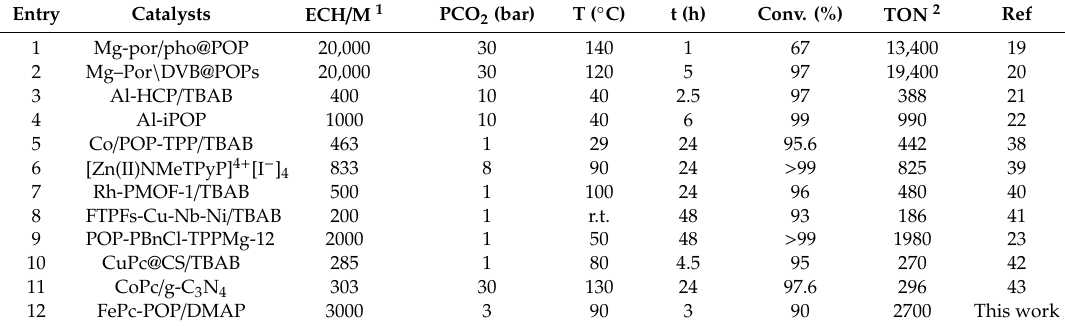
Table 3. Catalytic performance of heterogeneous porhyrin or phthalocyanine based catalysts in the thermal cycloaddition of CO 2 to ECH.